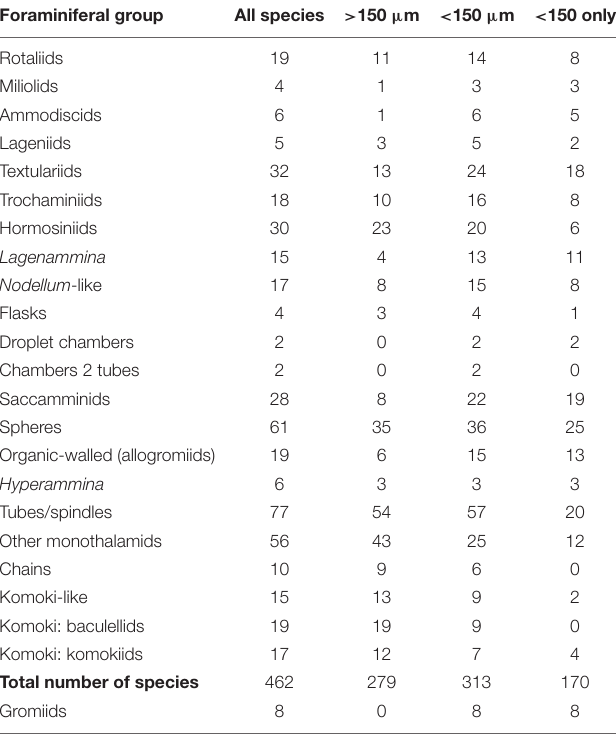
TABLE 6 | Number of morphospecies assigned to different foraminiferal groups, and to gromiids. Foraminiferal group